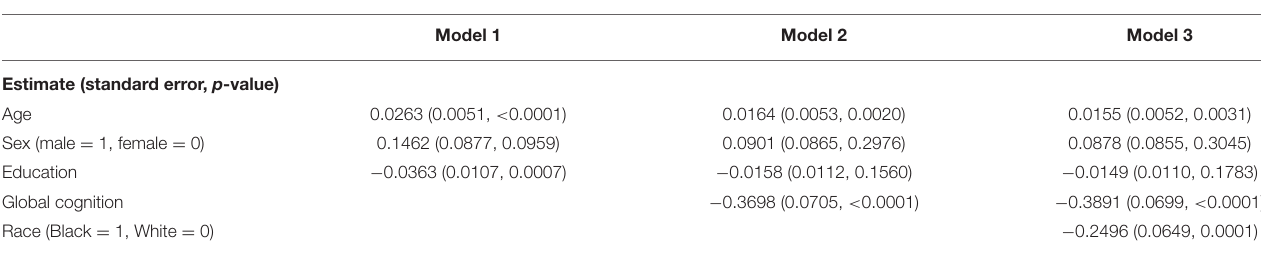
TABLE 2 | Association of race with susceptibility to scams.